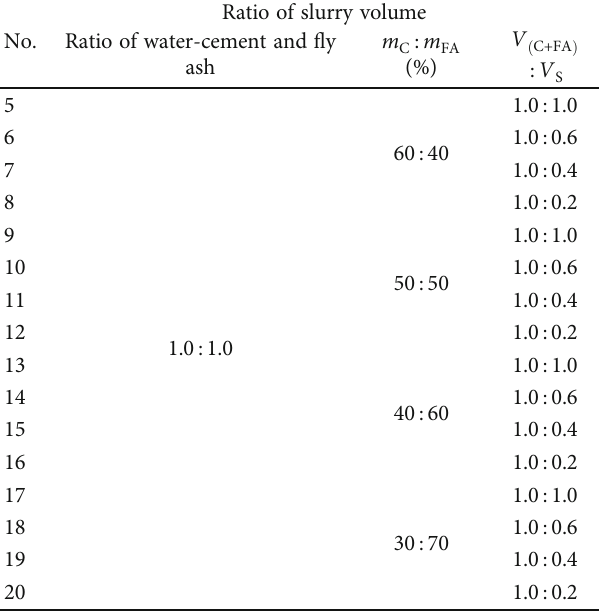
Table 5: Volume ratio of cement- fl y ash-sodium silicate slurry (C-FA-S).